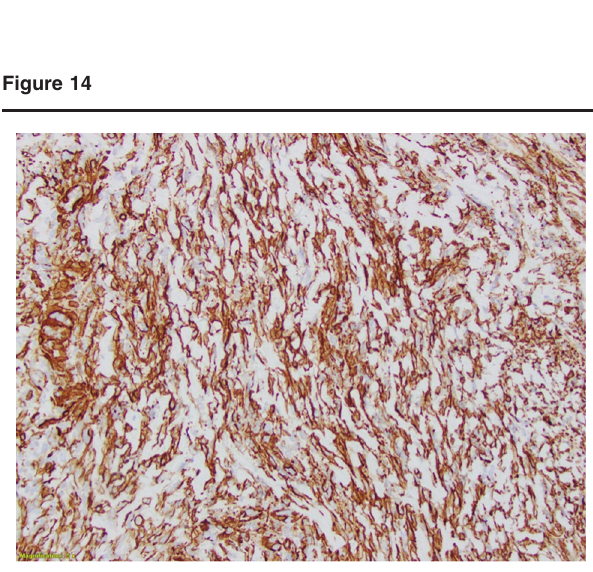
HE stain ×20 showing plump spindly tumor cells. Smooth muscle actin ×200 positive in tumor